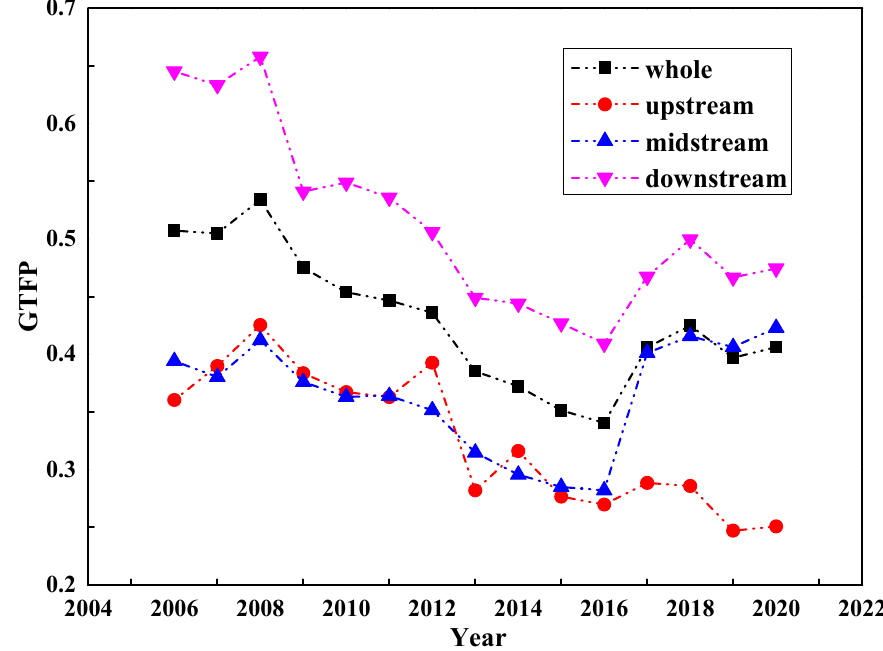
Figure 1. Trend of the urban GTFP in the YRB from 2006 to 2020.